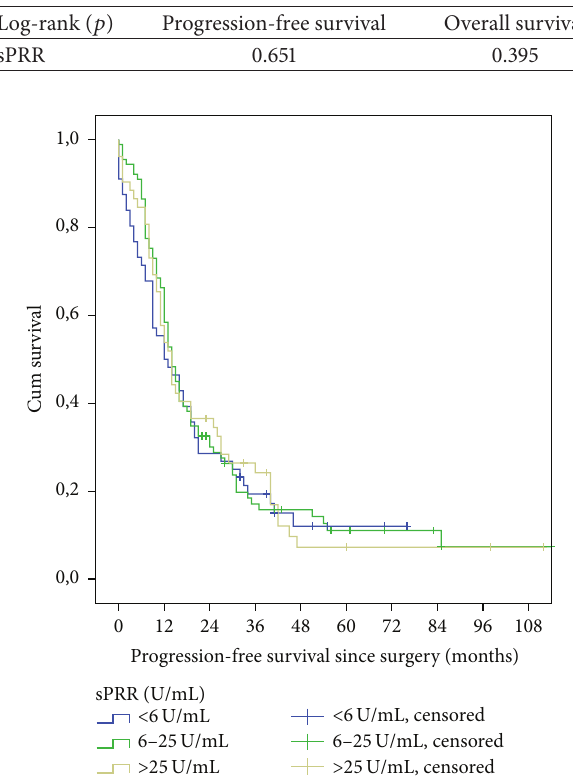
Table 5: Significance in equality log-rank tests (Mantel-Cox) of sPRR with PFS and OS.